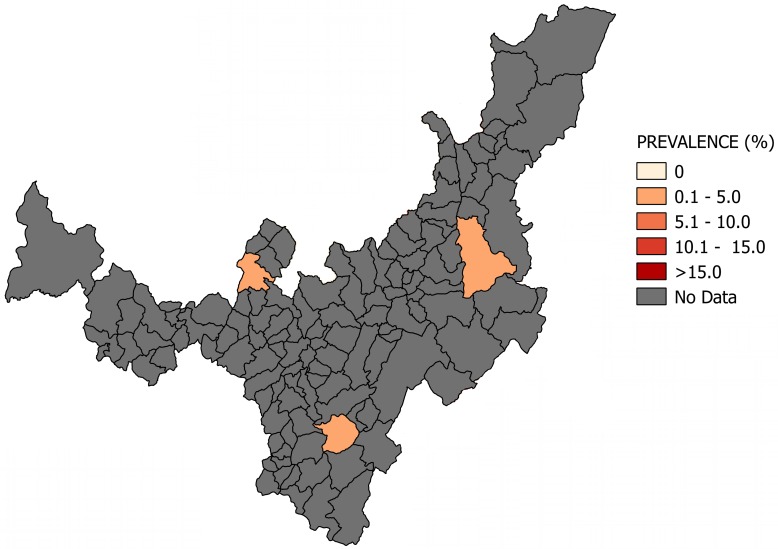
Map of the municipalities of Boyacá showing the distribution of observed Chagas disease prevalence in studies published from 2007 to November 2017.